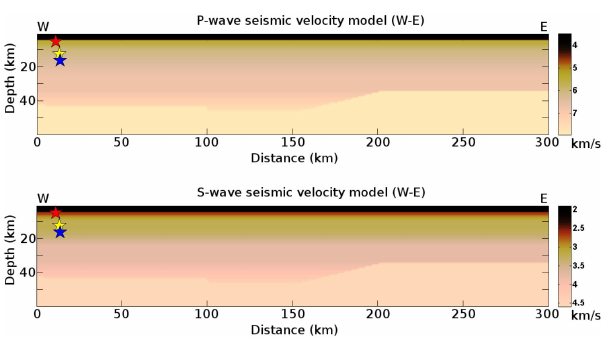
Figure 4. The 2-D velocity model tested to assess the influence of Moho structure. The Moho boundary has been based on the results of Papazachos and Nolet (1997). The position of Cephalonia is be- tween 0 and 50km. The hypocenters of the major events are shown with stars: blue for the event of 26 January 2014 ( M w = 6 . 0), yel- low for the aftershock on 26 January 2014 ( M w = 5 . 3), and red for the event of 3 February 2014 ( M w = 5 .